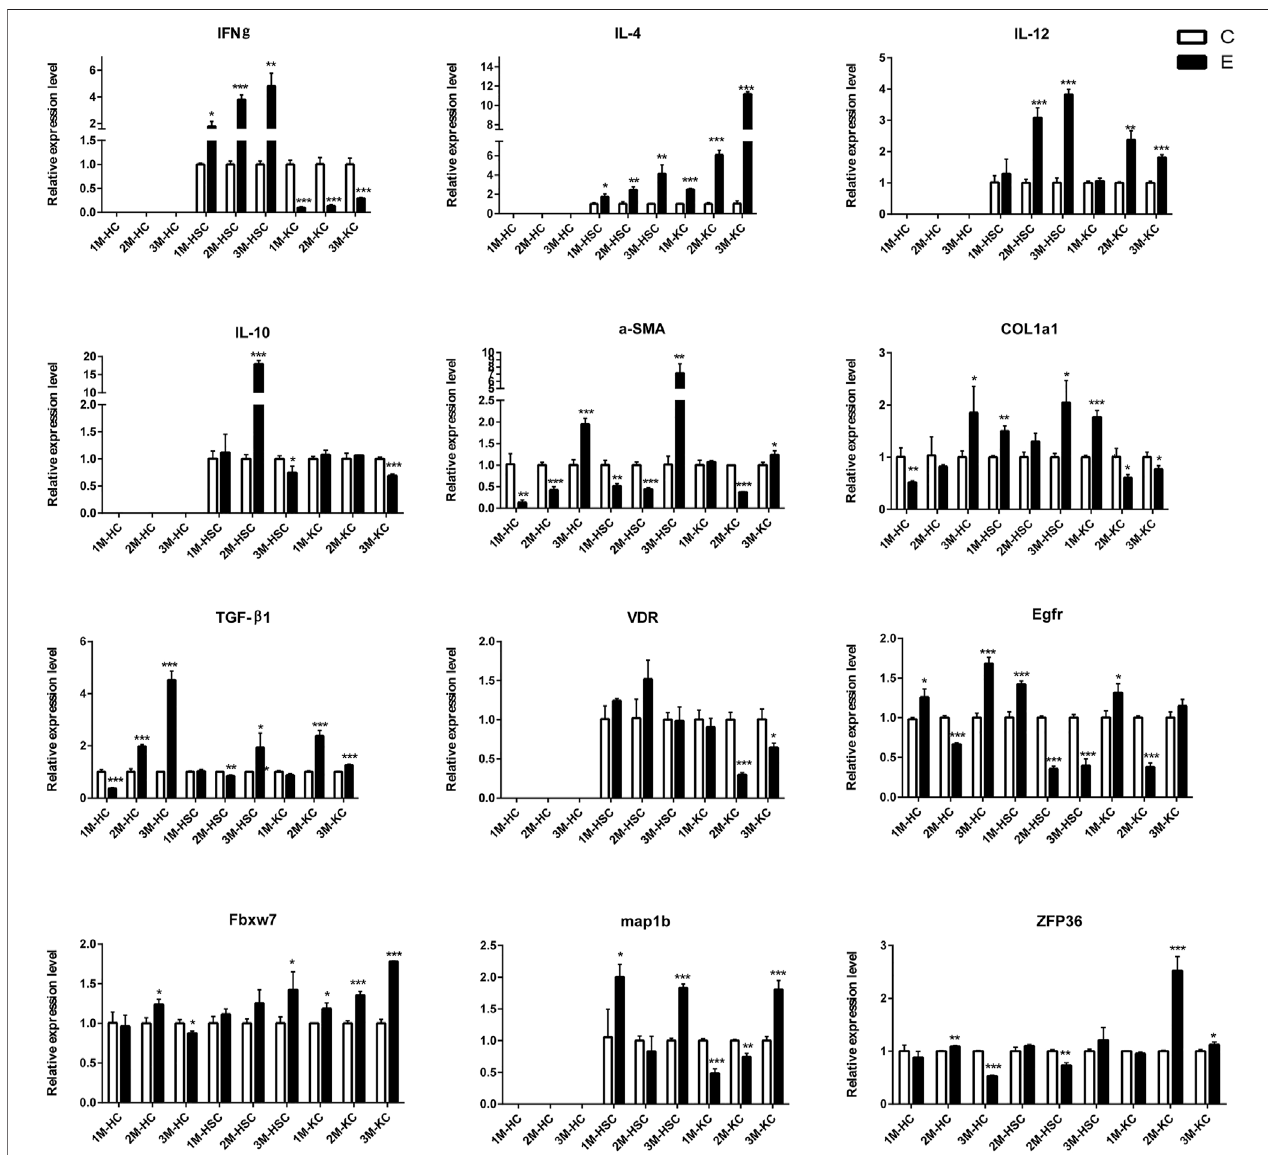
FIGURE5| Therelativeexpressionlevelsof12mRNAsin2M-HC,3M-HC, 2M-HSC,3M-HSC,2M-KCand3M-KCweredetermined byqRT-PCR.Thenumberof biologicalreplicates foreach experimentwas3and therelative expression levels werenormalized totheexpression levels ofGAPDH.Dataarepresented asmeanswith SD. p -values were analyzed by Student ’ s t -test. *** p < 0.001, ** p < 0.01 and * p < 0.05.